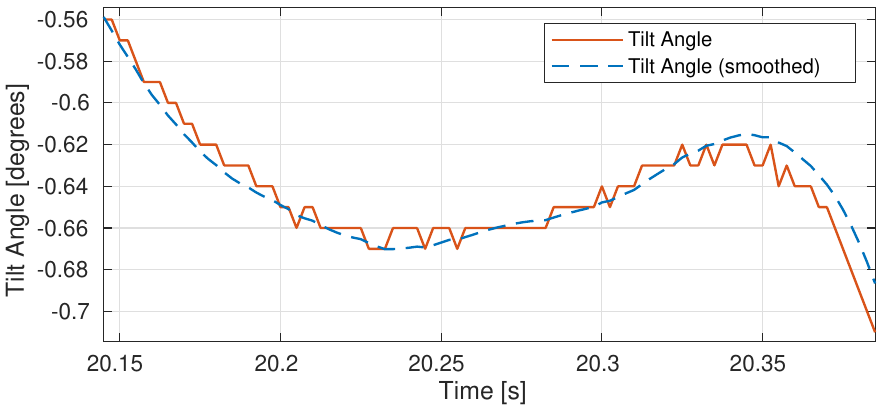
Figure 2. The raw tilt angle signal (from the IMU) and the results of the Smoothing